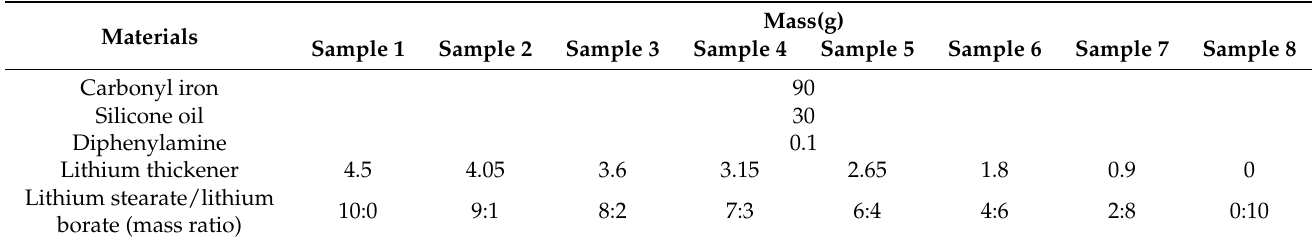
Table 1. Material compositions of composite lithium-based MR grease.